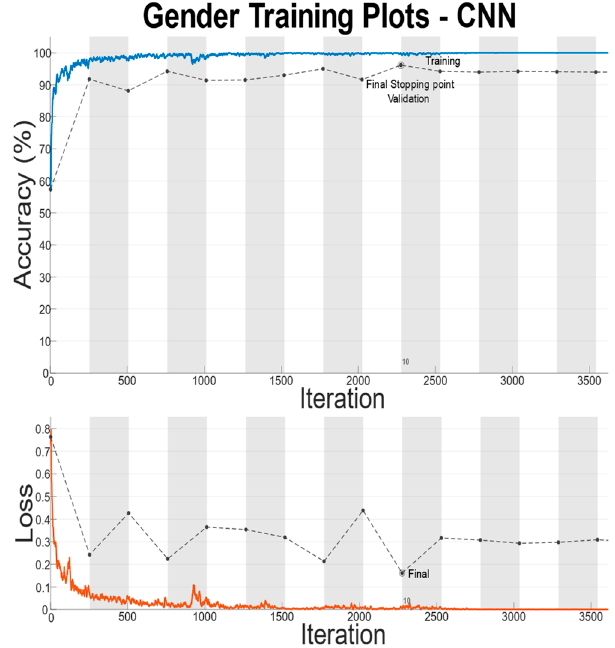
Figure 9. Training Plots for Best Performing Gender Network.